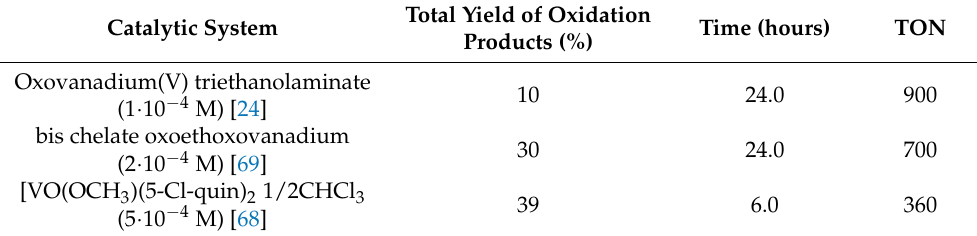
Table 2. Cont. Catalytic